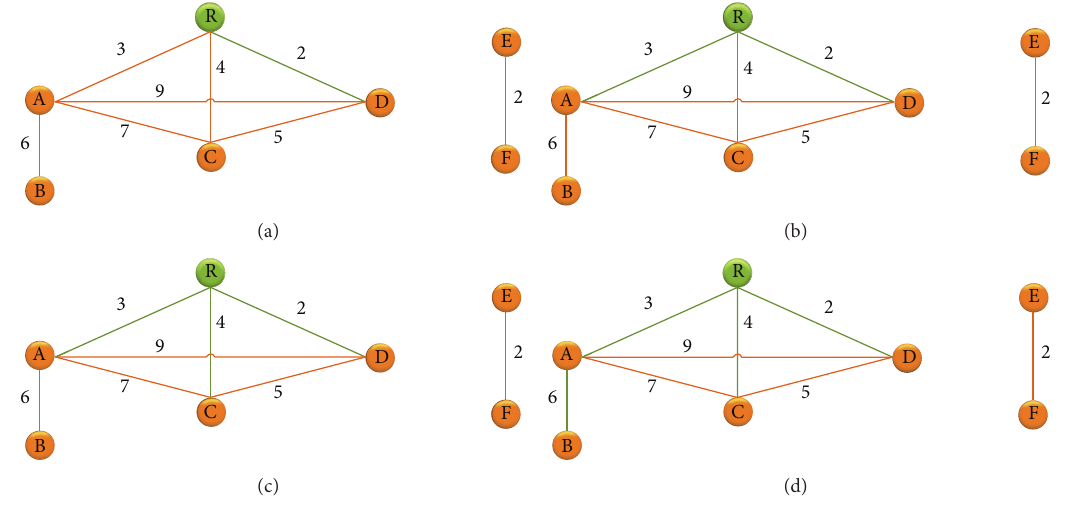
Figure 6: Process of the IPA on the basis of Figure